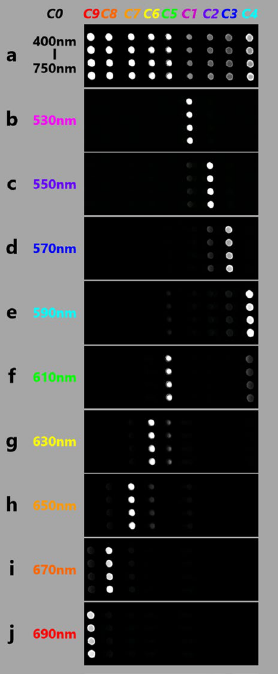
Figure 6. Spectroscopic performance of nine-color spectrometer. Four sets of nine-color split images ( C1 − C9 ) formed by the novel nine-color spectrometer when incident lights (four C0 s) are lights with wavelengths of ( a ) 400−750 nm (as in Fig. 5a), ( b ) 530 nm, ( c ) 550 nm, ( d ) 570 nm, ( e ) 590 nm, ( f ) 610 nm, ( g ) 630 nm, ( h ) 650 nm, ( i ) 670 nm, and ( j ) 690 nm,